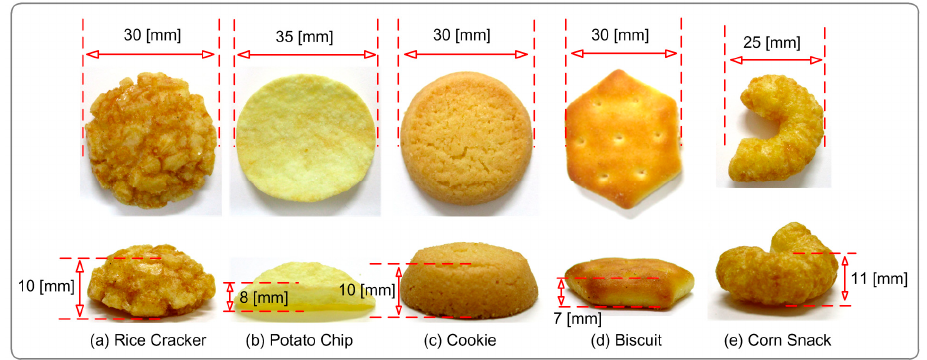
Figure 4. Food specimens: ( a ) A popular rice cracker in Japan; ( b ) smaller sized potato chip compared